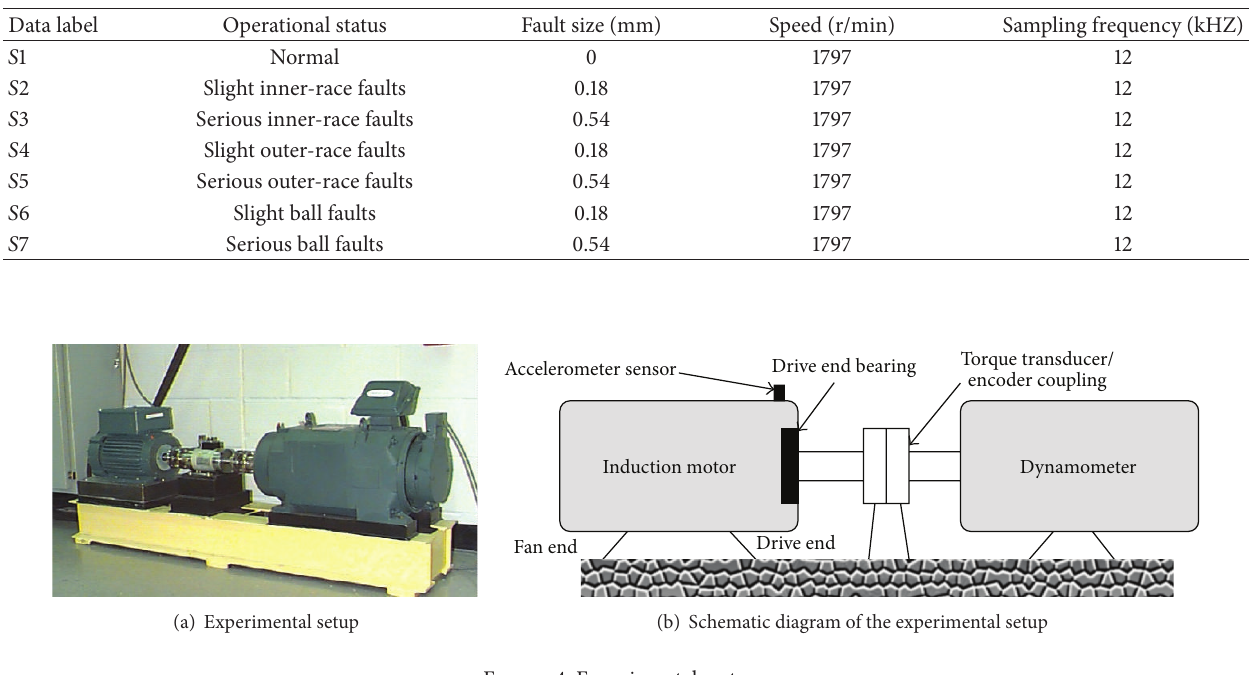
Table 1: The detailed descriptions of seven vibration signals.